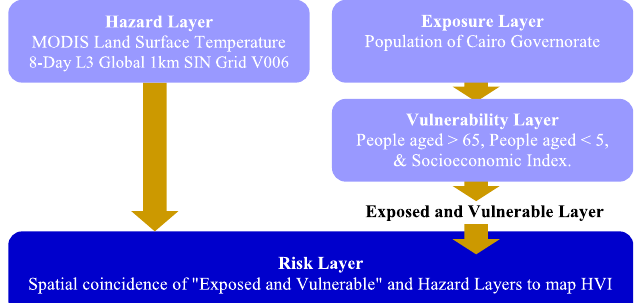
Fig. 6. Simpli fi ed work fl ow of the developed Geospatial Database to Map HVI. Source: Adopted and developed